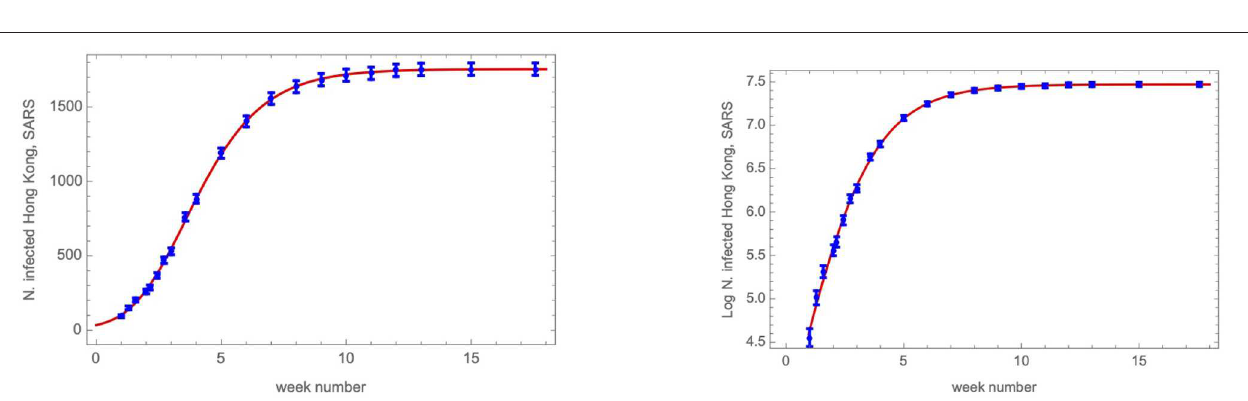
FIGURE 1 | How to flatten the curve. (Left) Hypothetical number of infected cases for two values of γ , i.e., γ = 1 (blue) and 0.5 (orange) as function of time keeping fixed the total number of infected cases. (Right) The corresponding number of new cases.